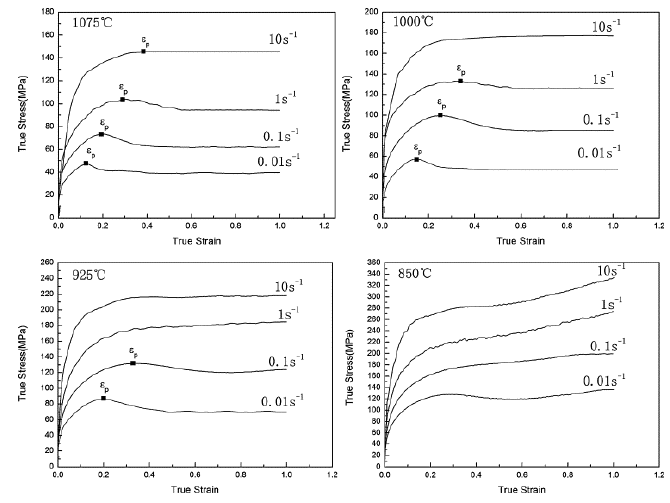
Figure 20. True stress–strain curve under different temperature and strain rates [115] .